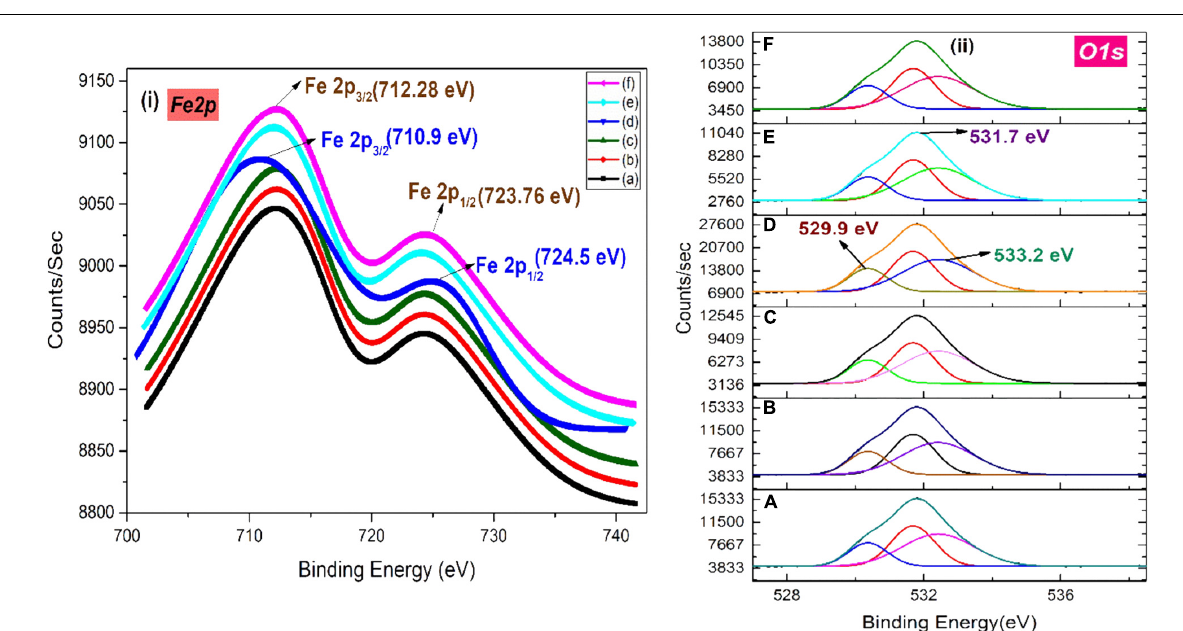
Figure 8ii represents the O1s core level; peaks at 529.9 and 531.7 eV can be associated with the existence of O − 2 and OH − species present at the iron oxide surface, respectively, and another peak at 533.2 eV is the indication of adsorbed H 2 O molecules (Medina-Llamas and Mattia,